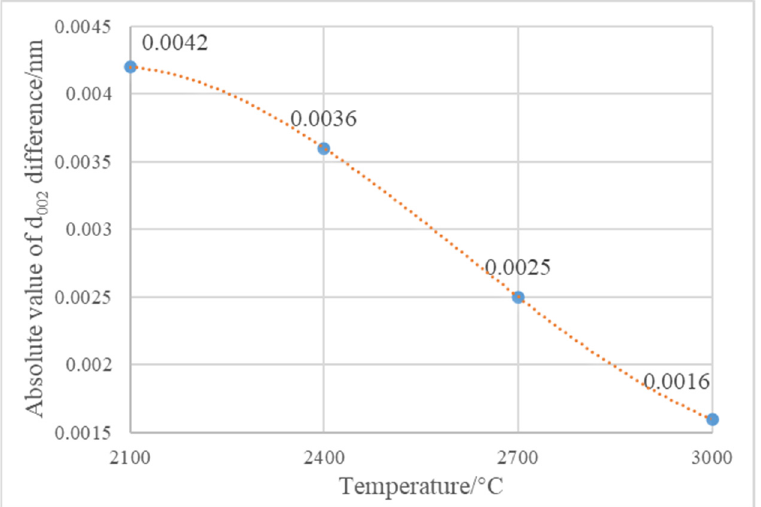
Figure 7. d 002 differences of G and GS sample evolution characteristics with temperature.